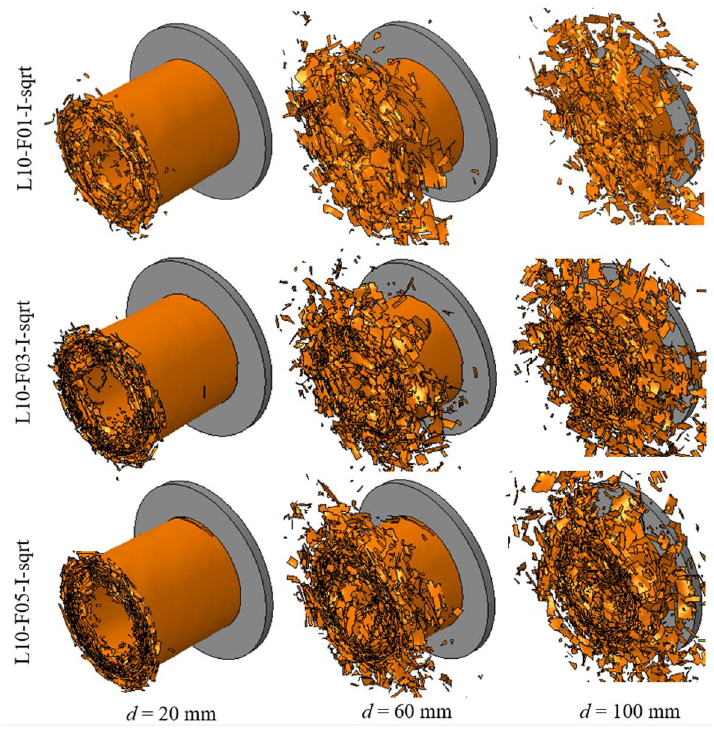
Figure 9. Simulated crushing process of the composite tube with friction coefficients of 0.1, 0.3, and 0.5.